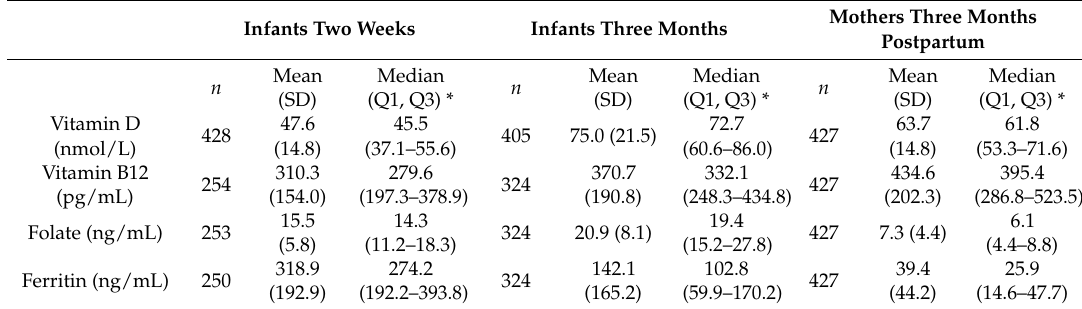
Table 3. Descriptive statistics for infant and mothers micronutrient status.